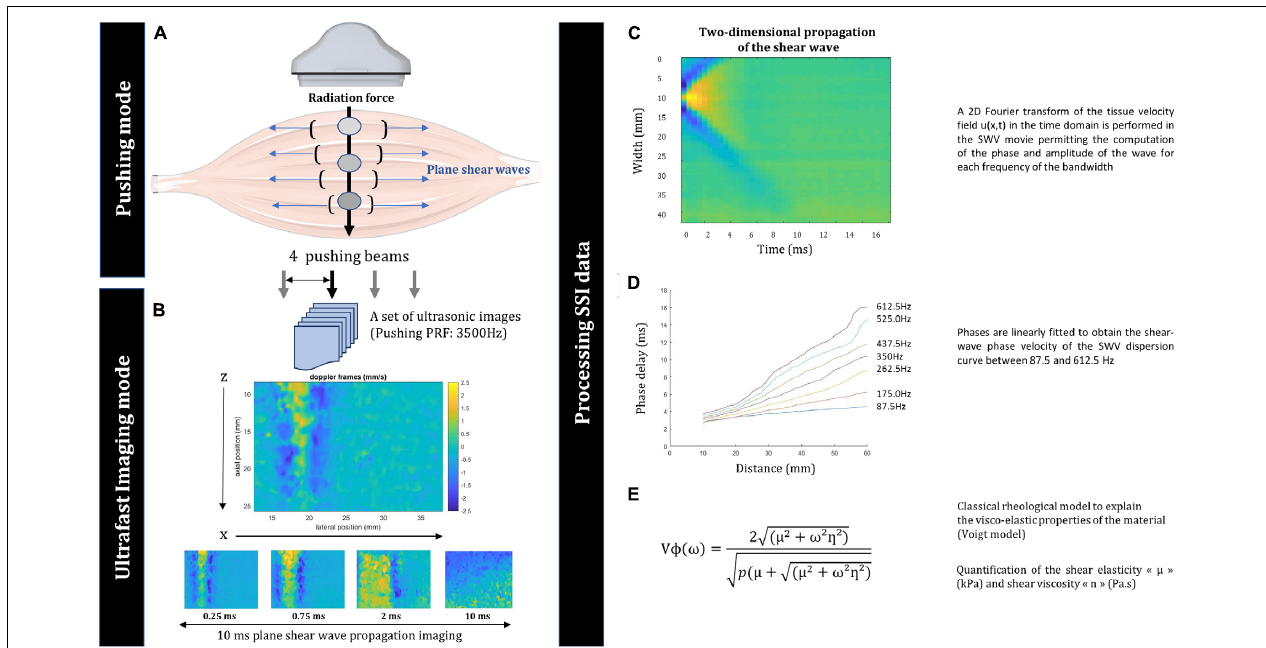
FIGURE 2 | Schema of the imaging setup with the ultrasound transducer (A) . Ultrafast imaging mode: the propagation of the planar shear waves of the first pushing beam is shown over 10 ms (B) . Processing of the supersonic imaging data: velocity field of the shear-wave velocity along the fibers (C) , relationship between the phase delay (ms) and the distance (mm) (D) , and rheological model used to explain the viscoelastic properties of muscle (E)